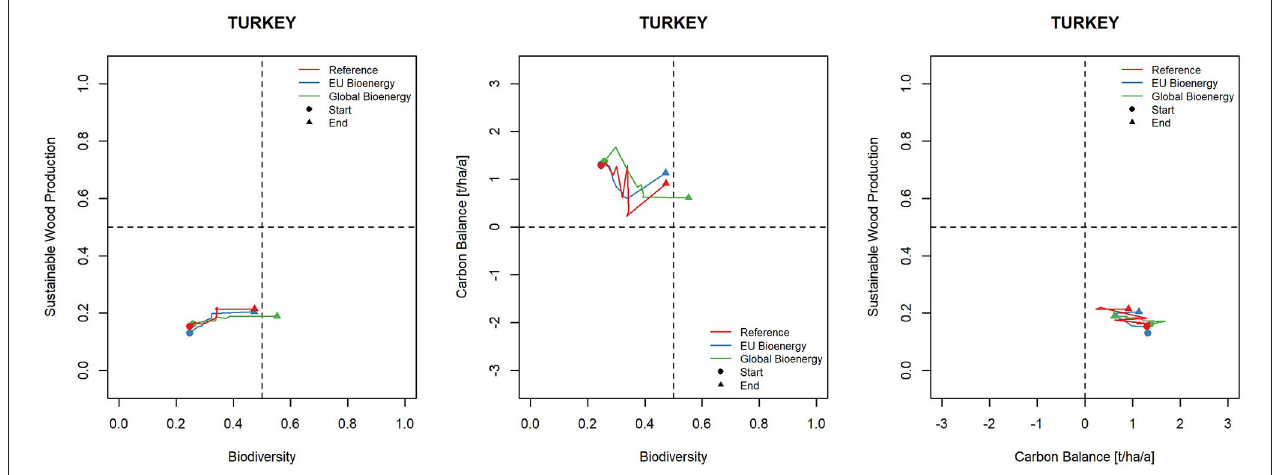
FIGURE 10 | Trade-off diagrams for Turkey.